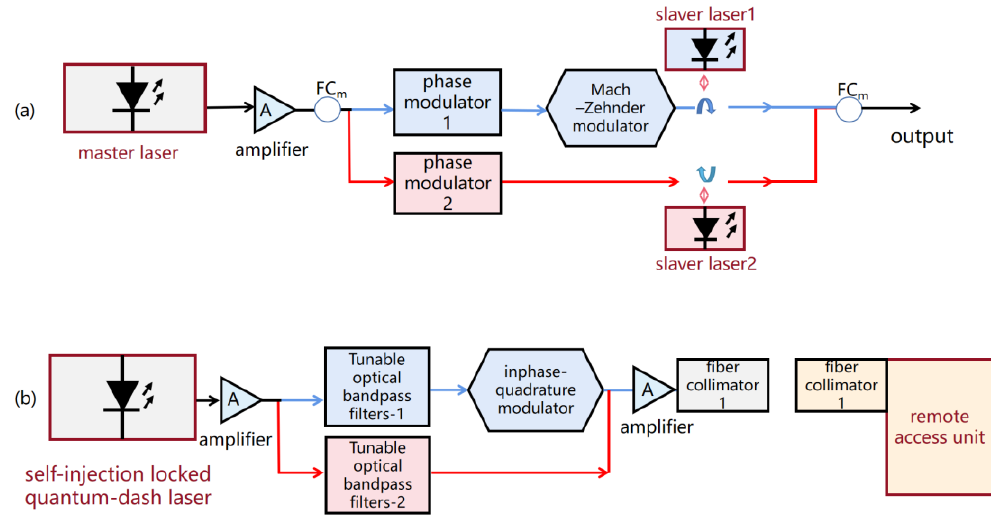
Figure 2. ( a ) The perturbed P1 dynamics of semiconductor lasers for frequency-modulated continuous-wave generation with external injection locking [8]; ( b ) A self-injection-locked quantum dash LD comb source, based on a 50/75 GHz mmWave transport system [11].